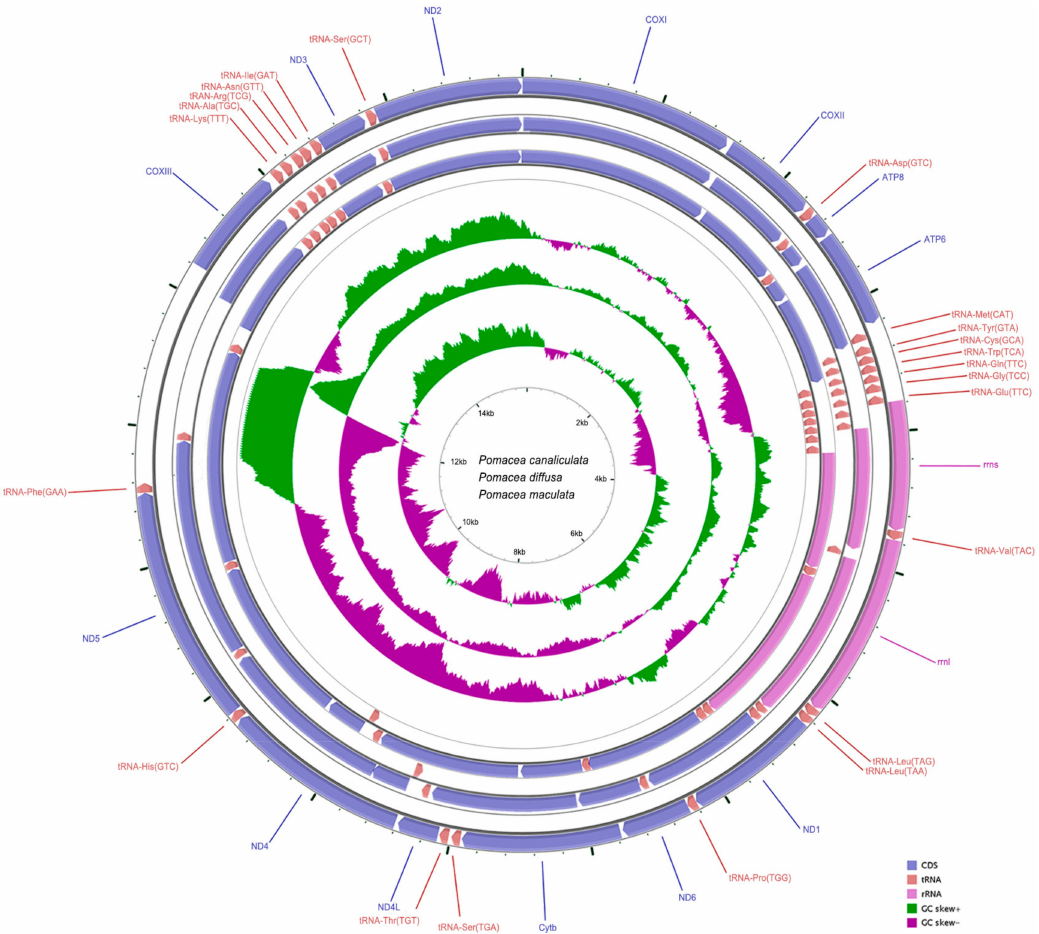
Figure 1. Gene map of the complete mt genomes for P. canaliculata (GenBank accession No. KU052865), P. diffusa (KY008698) and P. maculate (KY008699). The larger ring indicates gene arrangement and distribution. The smaller ring indicates the GC content. ND1-6 : NADH dehydrogenase subunits 1–6; COXI-III : cytochrome c oxidase subunits 1–3; ATP6 and ATP8 : ATPase subunits 6 and 8; Cytb : cytochrome b; rrn : ribosomal RNA genes; tRNA : transfer RNA